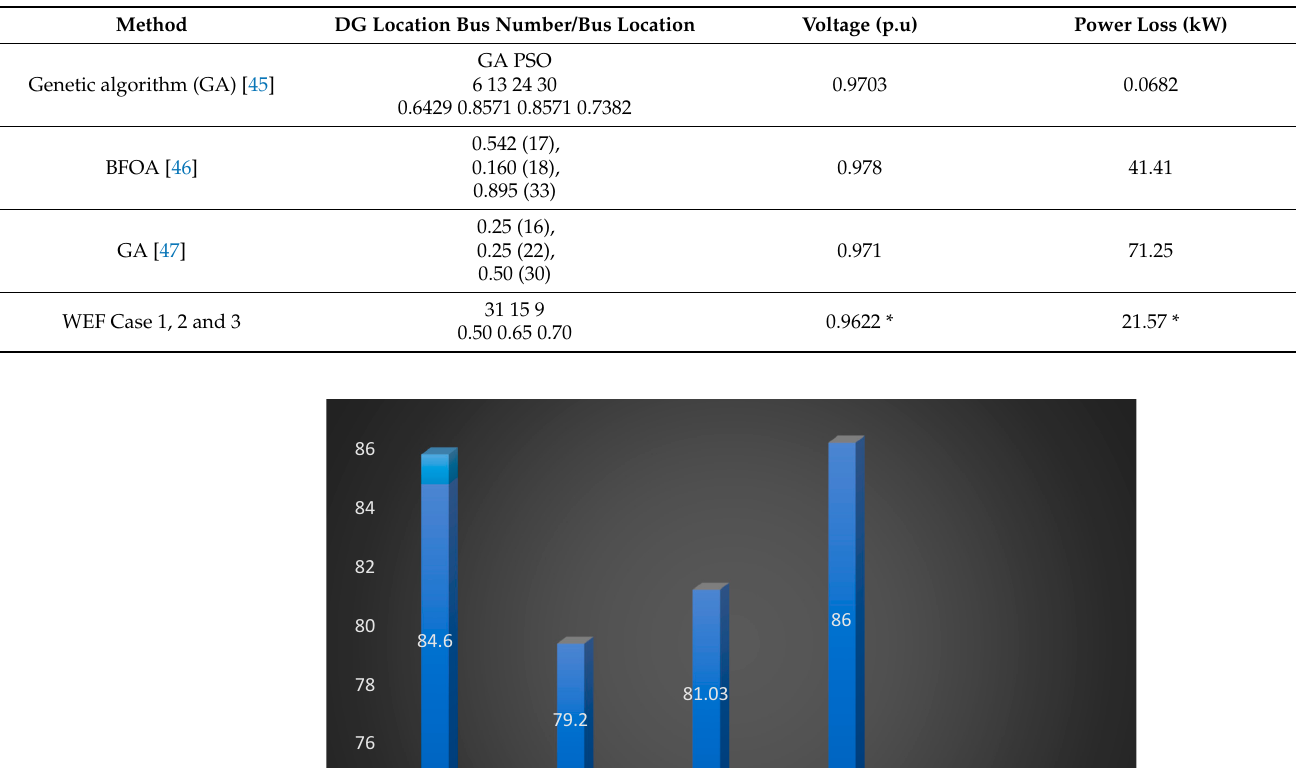
Table 5. Compares the results of the various methods for the test systems for the allocation of a single and multiple DG units.